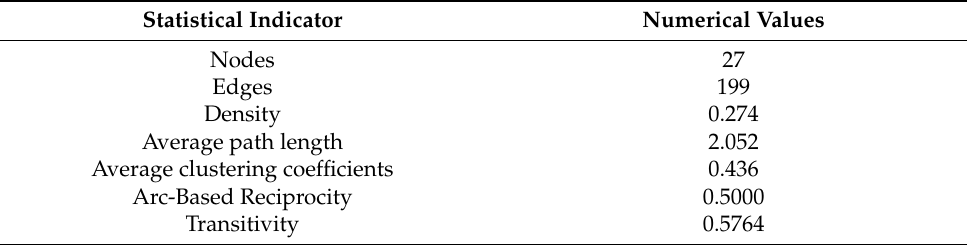
Figure 1. Overall interdependency network of NI in Chongqing. Table 1. Results of social network